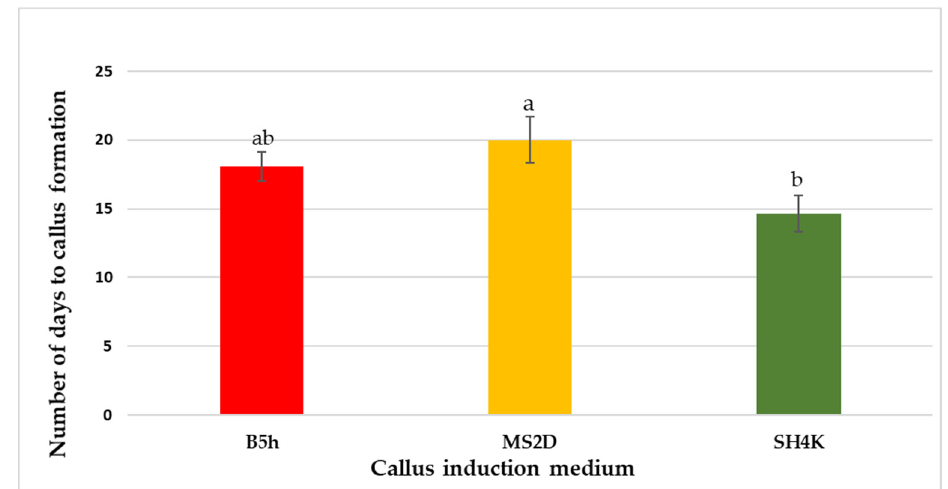
Figure 1. Number of days to callus formation on a different callus induction medium. Different letters indicate a significance difference according to the Tukey Kramer honestly significance difference (HSD) test at p ≤ 0.05 and values represent mean ± SD ( n = 30).